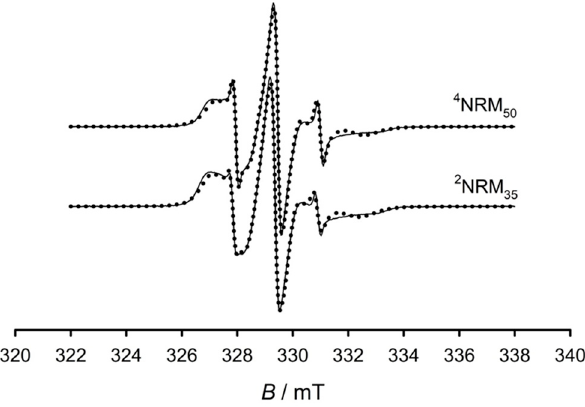
Figure 6. The ESR spectra of 2 NRM 35 and 4 NRM 50 semi IPNs at 75 °C.